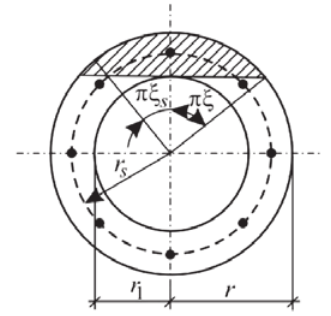
Fig. 2. Modelling of annular cross-section for reinforcement concrete